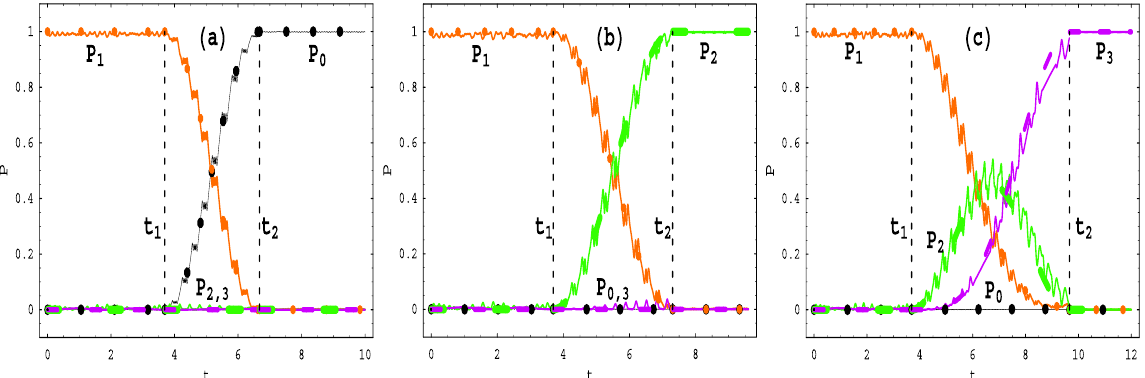
Figure 4. Time evolutions of the transition probabilities from the initial SLS | ψ 12 ( t ) 〉 to other final SLSs. ( a ) The parameters are the same as those of Fig. 3(a); ( b ) The parameters are the same as those of Fig. 3(a) except for